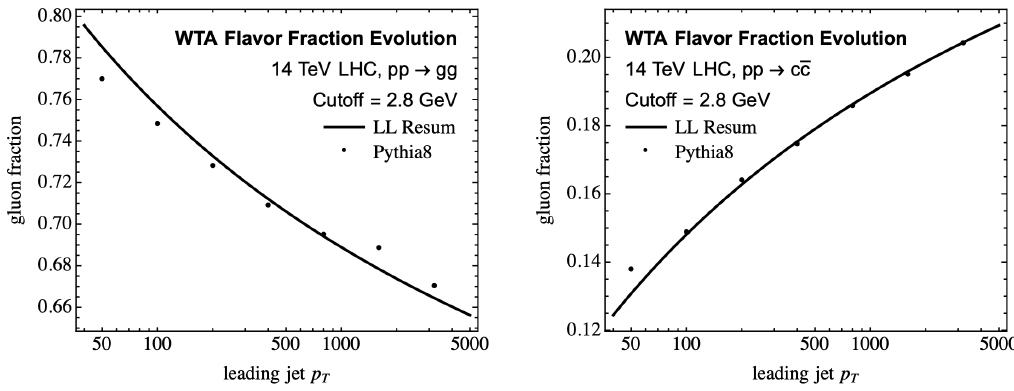
Figure 2 . Comparison of fraction of WTA gluon flavor jets from initial high- p ⊥ gluon jets (left) or charm jets (right) in simulation (dots) and leading-logarithmic analytic evolution